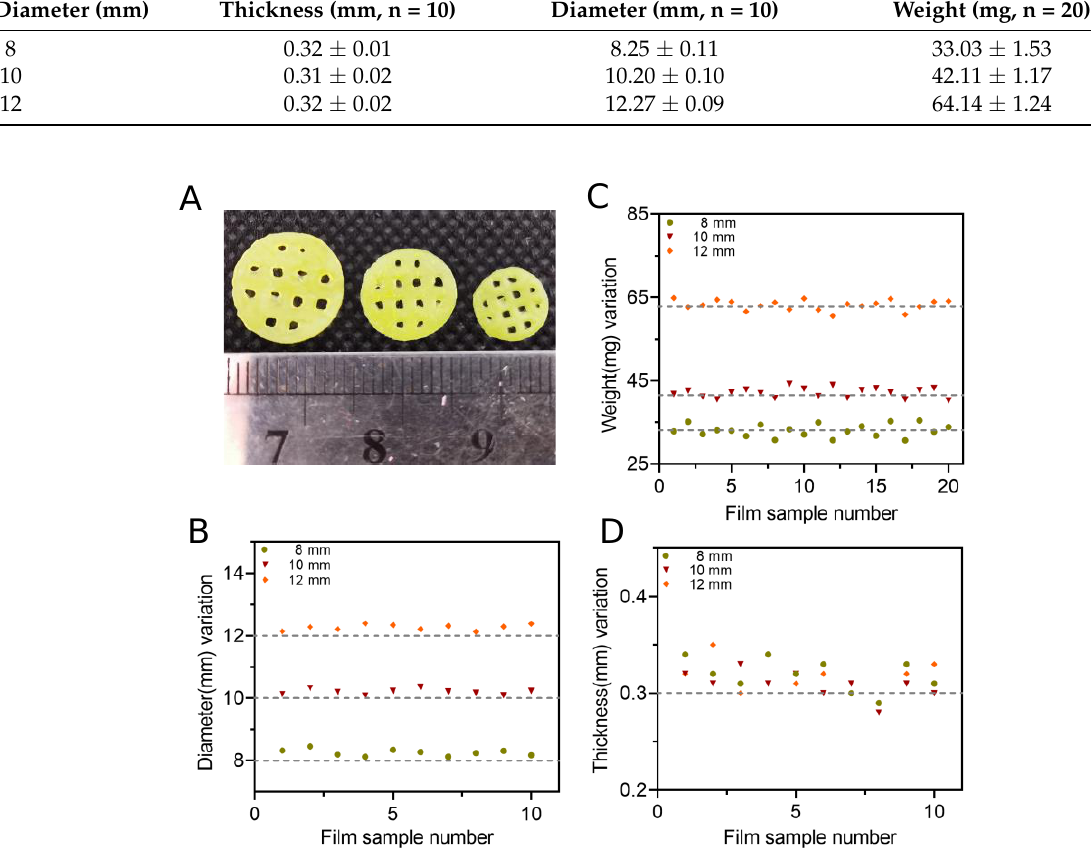
Figure 9. ( A ) Appearances of 3D-printed oral films with three different diameters; ( B ) diameter variation of oral films (n = 10); ( C ) weight variation of oral film (n = 20) and ( D ) thickness of oral films (n = 10).